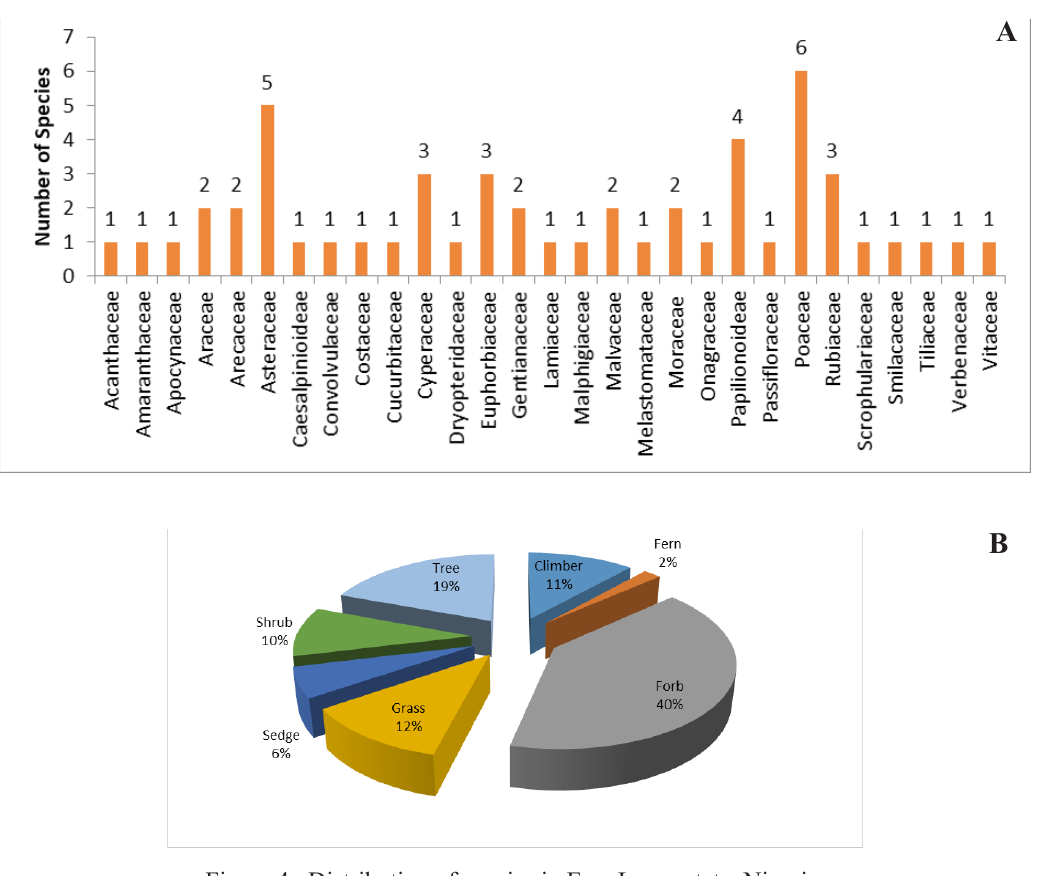
Figure 4. Distribution of species in Epe, Lagos state, Nigeria. A: Family distribution; B: Percentage distribution of Plant